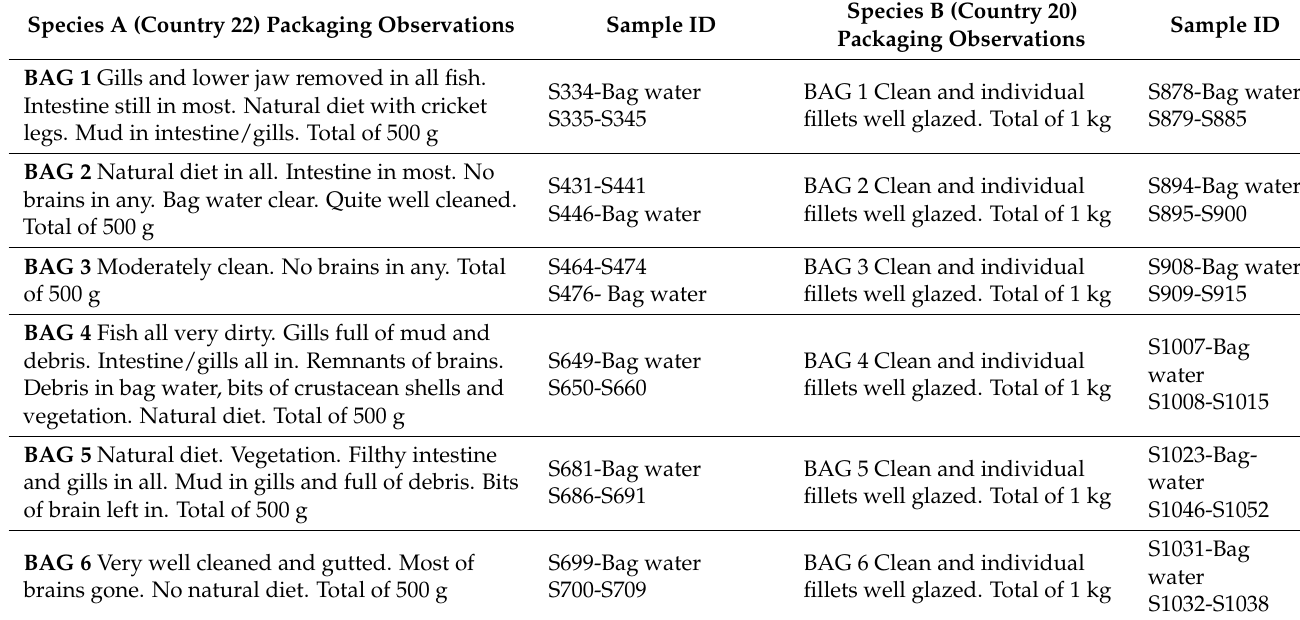
Table 1. Processing observations of fish and packaging in this study and corresponding sample